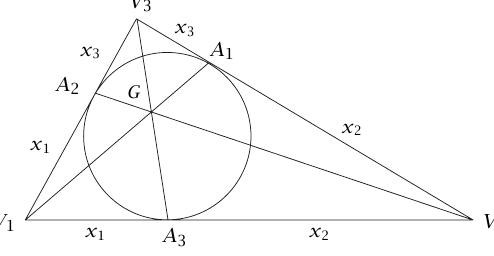
Figure 2 . ∆ V 1 V 2 V 3 , Incircle C(I) and Gergonne point G .